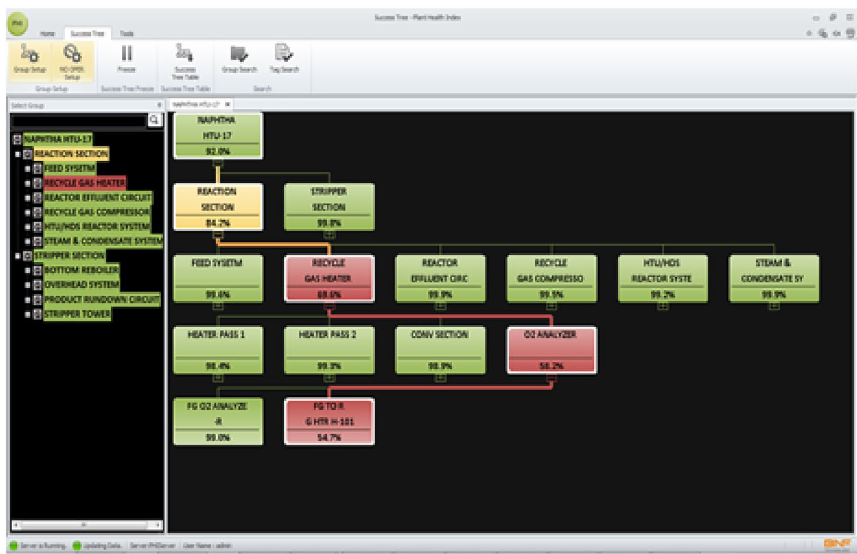
Figure 14. Success tree for the Hydrotreating